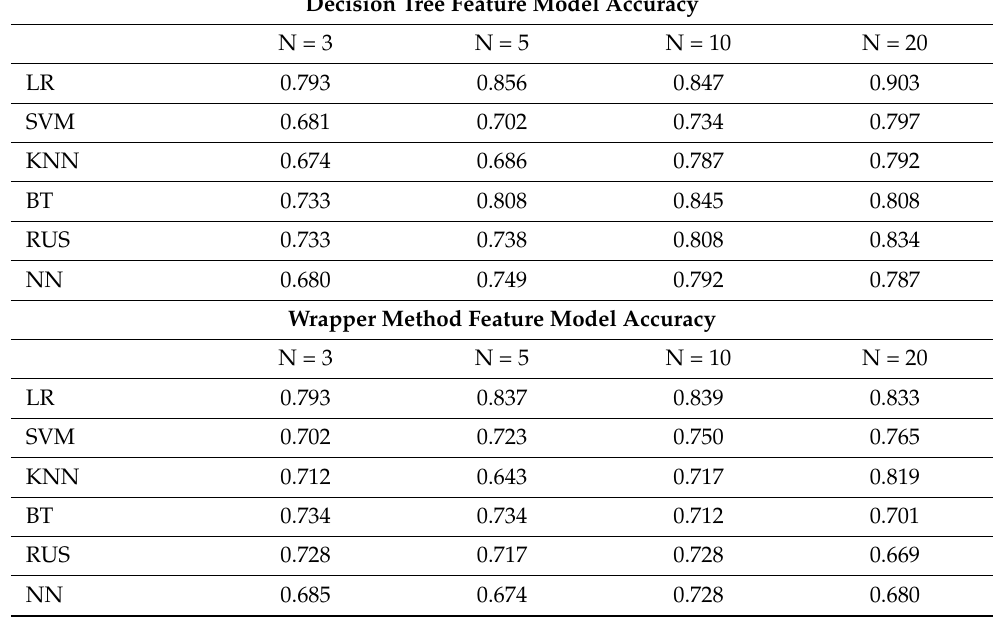
Table 4. Model performances for log-regression (LR), support vector machine (SVM), k-nearest neighbor (KNN), Bagged Trees (BT), RUSBoost Trees (RUS), and medium sized neural network (NN) using 0.25 mm resampling